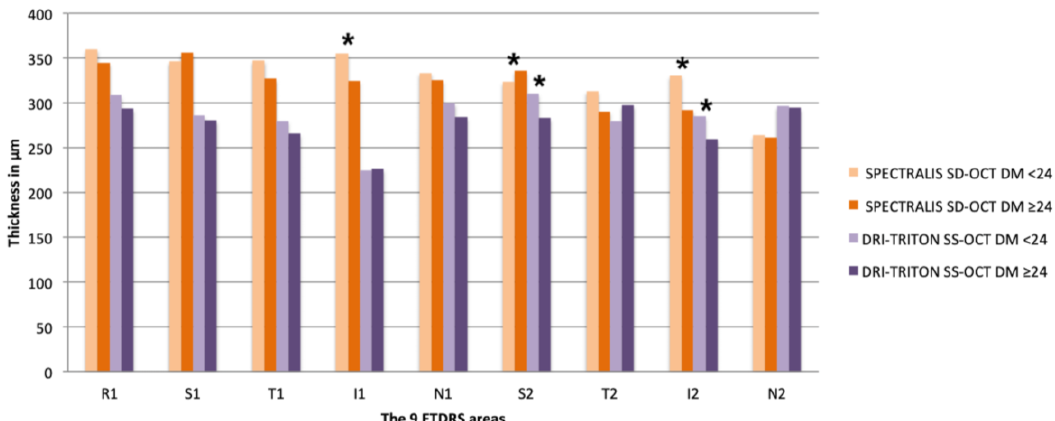
Figure 4. Mean of choroidal thicknesses in each ETDRS area in μm (from the BM to the choroid-scleral limit) assessed with Spectralis spectral domain optical coherence tomography (SD-OCT) and the deep range imaging (DRI)-Triton swept source optical coherence tomography (SS-OCT) in the type 1 diabetes Mellitus (DM1) group subdivided into two groups: less than 24 years and over or equal to 24 years of evolution of DM1. Significant differences were considered as p < 0.05, calculated by Kolmogorov–Smirnov test for two independent nonparametric samples, are shown with *. SD-OCT, spectral domain optical coherence tomography; DRI, deep range image; SS-OCT, swept source optical coherence tomography; DM, diabetes mellitus; ETDRS, Early Treatment Diabetic Retinopathy Study; R1, central; S, superior; T, temporal; I, inferior; N, nasal. The number 1 corresponds to the 3 mm parafoveal inner circle and 2 to the 6 mm perifoveal outer circle.